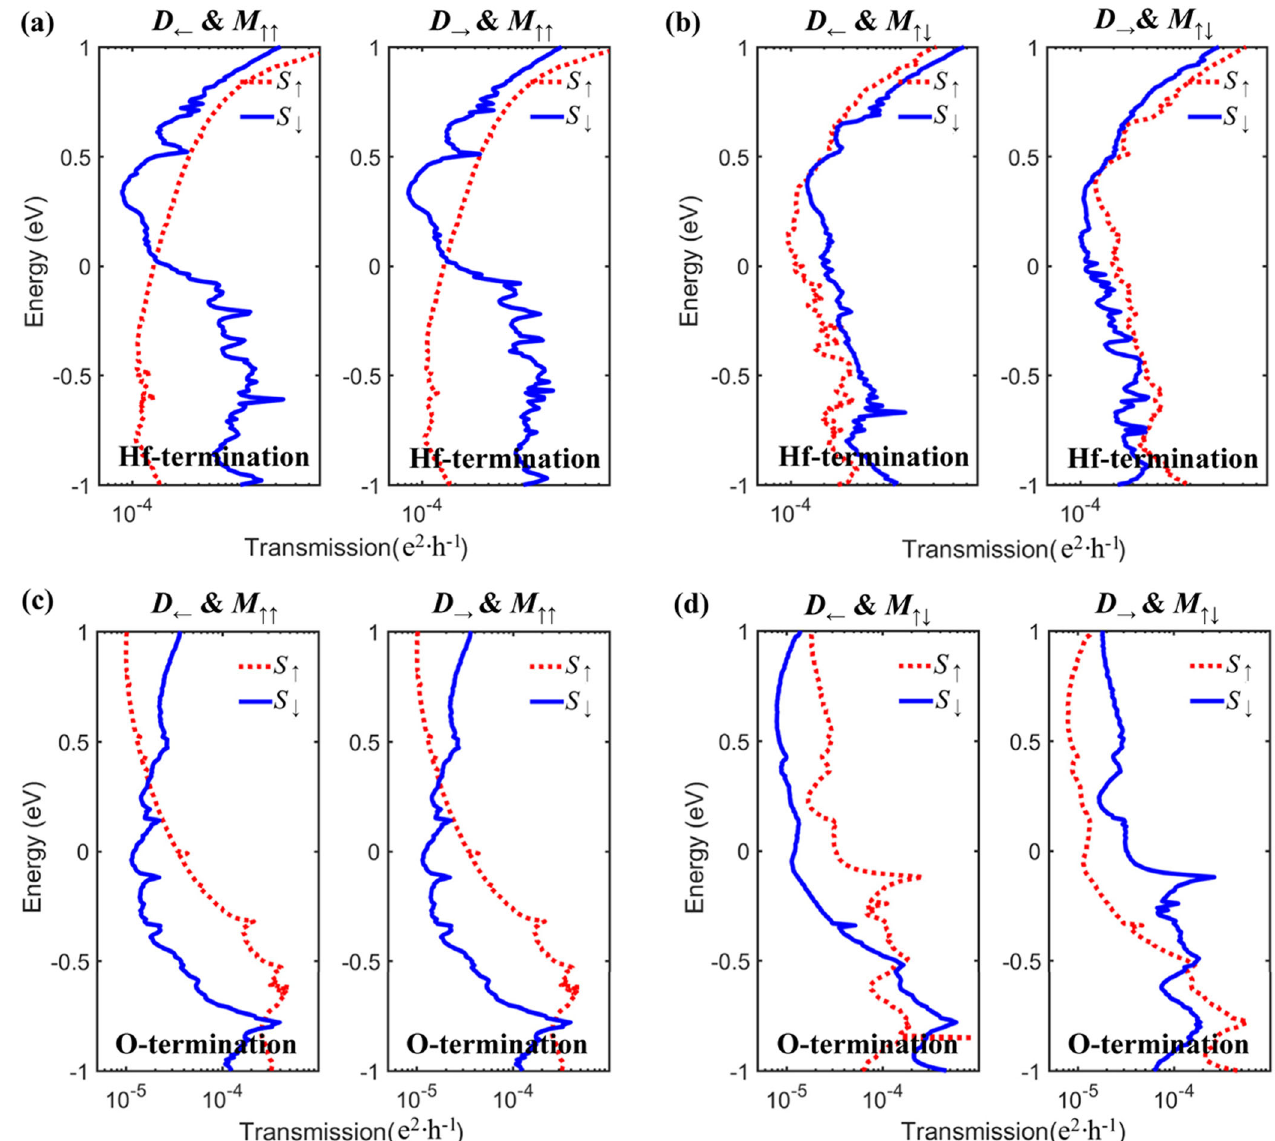
Fig. 3 Spin dependent transmissions of Co/HfO 2 /Co junctions. Transmission of Co/HfO 2 /Co junctions with symmetric interface terminations at different oxygen displacements ( D ) and ferromagnetic ( M ) polarization states: ( a , b ) the Hf-terminated structure, ( c , d ) the O-terminated